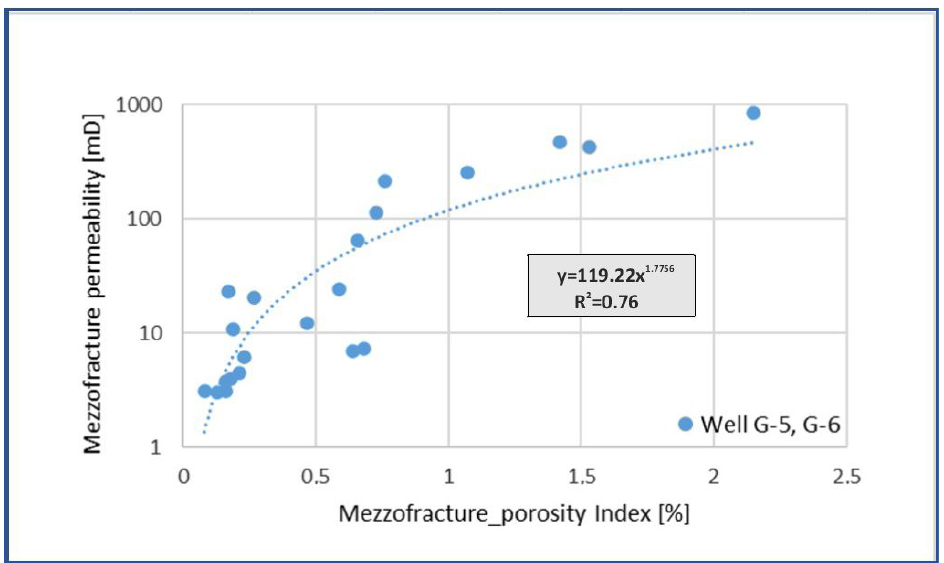
Figure 9. Relation between mezzofracture permeability and Mezzofracture_porosity Index; boreholes G-5 and G-6.